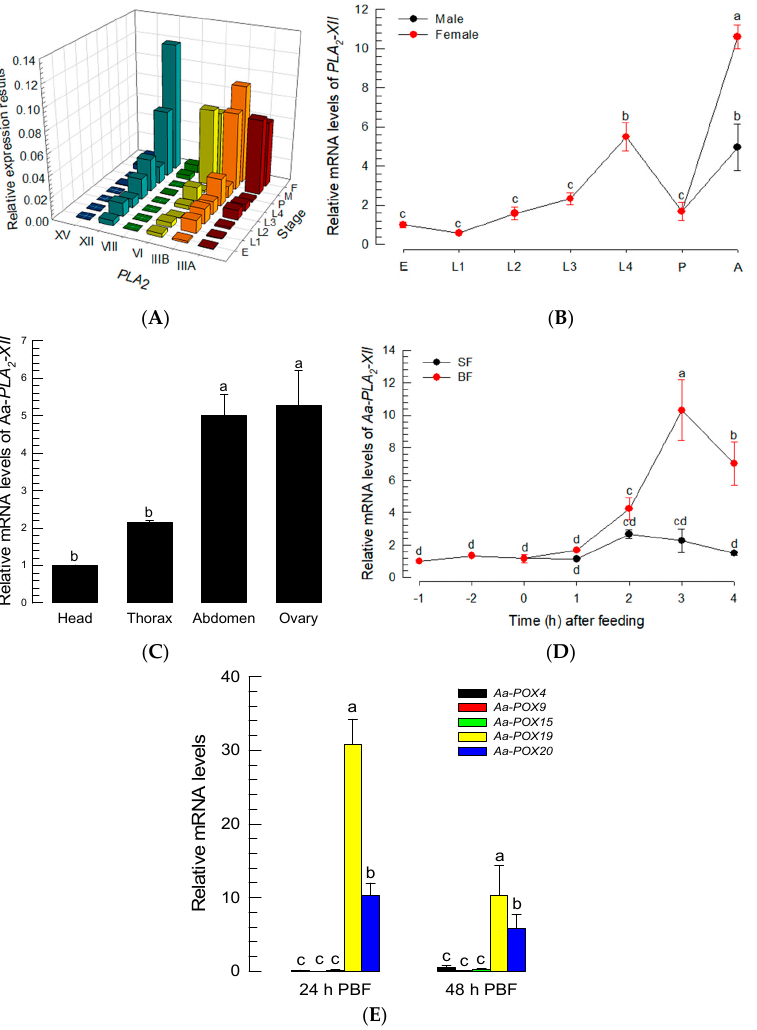
Figure 4. Prediction of PLA 2 and COX-like POX genes in PG biosynthesis of Ae. albopictus . ( A ) Expression profiles of six Aa-PLA 2 s at different developmental stages: ‘E’ for egg, ‘L1-L4 ′ for 1st-4th instar larvae, ‘P’ for pupa, ‘M’ for male, and ‘F’ for female. Expression levels of Aa-PLA 2 -IIIA (‘IIIA’), Aa-PLA 2 -IIIB (‘IIIB’), Aa-PLA 2 -VI (‘VI’), Aa-PLA 2 -VIII (‘VIII’), Aa-PLA 2 -XII (‘XII’), and Aa-PLA 2 -XV (‘XV’) were analyzed by RT-qPCR. ( B ) Expression profiles of Aa-PLA 2 -XII in male and female mosquitoes. ‘A’ stands for adults. ( C ) Expression profile of Aa-PLA 2 -XII in the different tissues of adult female mosquitoes. ( D ) Effects of sugar-feeding (‘SF’) and blood-feeding (‘BF’) on the expression of Aa-PLA 2 -XII . ( E ) Expression profiles of five Aa-POX genes PBF. Each treatment was replicated three times with independent tissue preparations. The different letters above the standard error bars indicate significant differences among means at Type I error = 0.05 (LSD test).